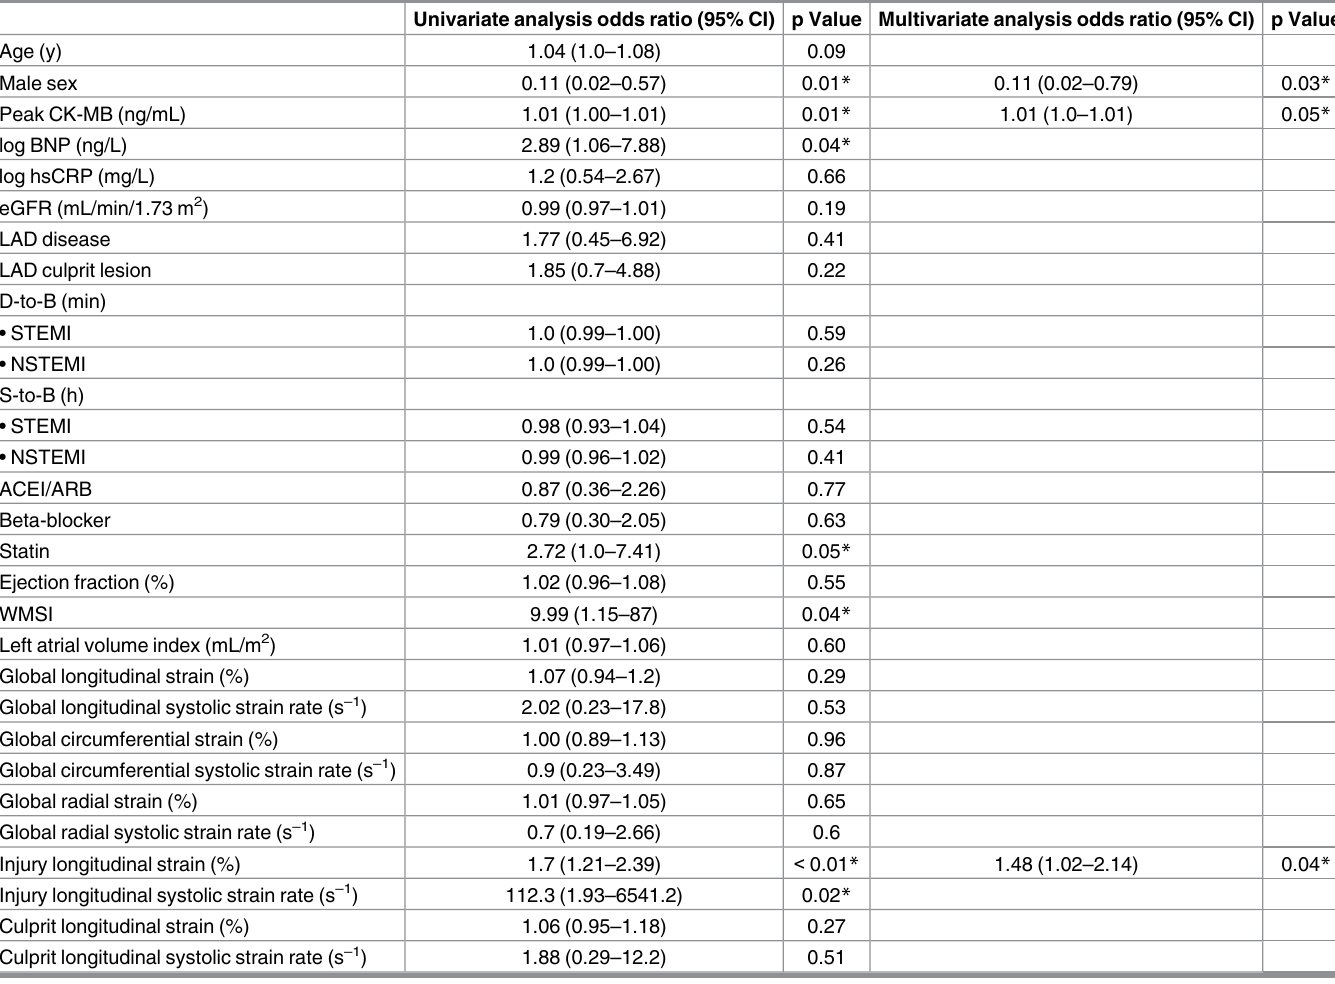
Table 4. Univariate and multivariate logistic regression for left ventricular